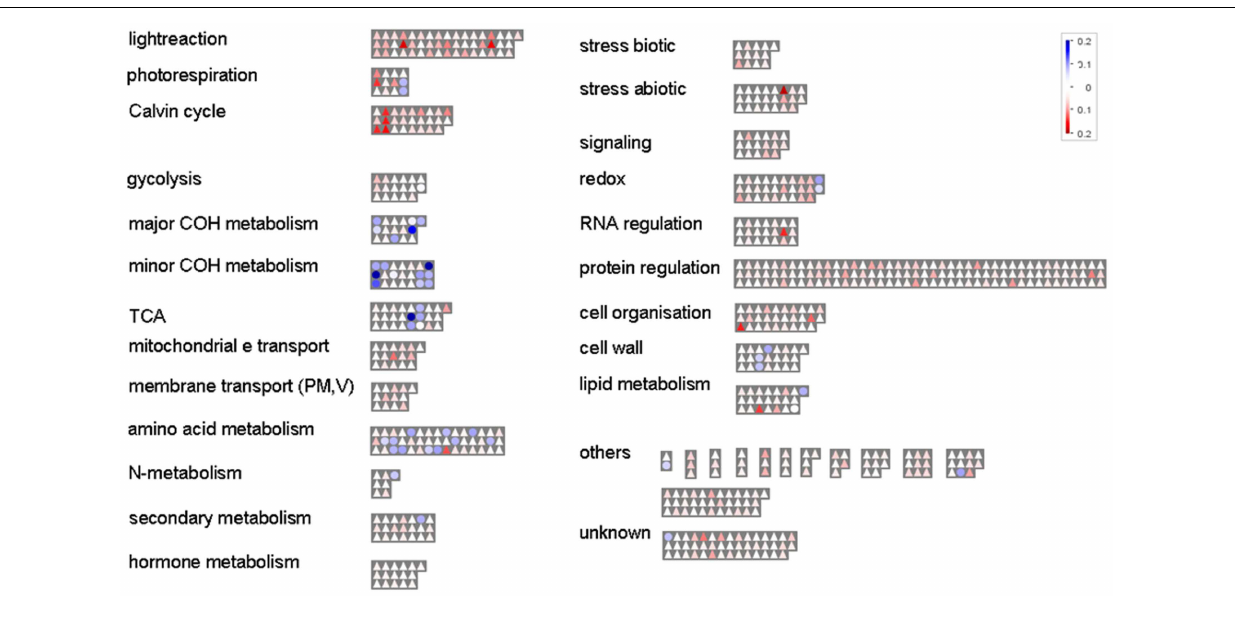
of peak area normalized by DW and IS) identified.Triangles = proteins; circles = metabolites.The strength of the color indicates the abundance of the compounds.